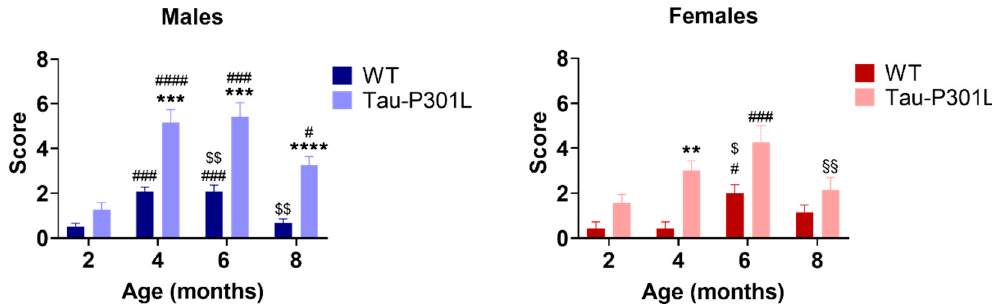
Figure 2. Tau-P301L male mice show phenotypic alteration in the SHIRPA test battery. Both Tau-P301L mice and WT were evaluated at 2, 4, 6 and 8 months of age. At 4, 6 and 8 months of age, Tau-P301L male mice ( n = 12) had a higher score compared to the age-matched WT male mice ( n = 12). Only at 4 months of age, Tau-P301L female mice ( n = 7) had a higher score compared to the age-matched WT female mice ( n = 7). Two-way ANOVA was performed. **: p < 0.01, ***: p < 0.001 and ****: p < 0.0001 compared to the age-matched WT. #: p < 0.05, ###: p < 0.001 and ####: p < 0.0001 compared to 2 months, genotype-matched. $: p < 0.05 and $$: p < 0.01 compared to 4 months, genotype-matched. §§: p < 0.01 compared to 6 months, genotype-matched. Data are given as mean ± SEM.